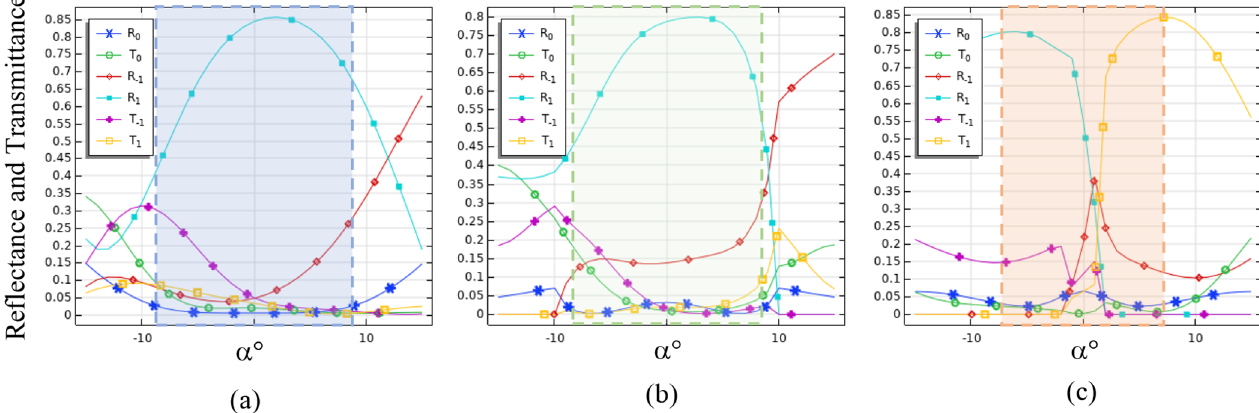
Fig. 9. Diffraction performance of the TiO 2 metagrating for (a) blue, (b) green and (c) red light. The angular ranges in-coupled by the system are shaded. The incidence angles correspond to the incidence from the medium with refractive index n 3 (waveguide